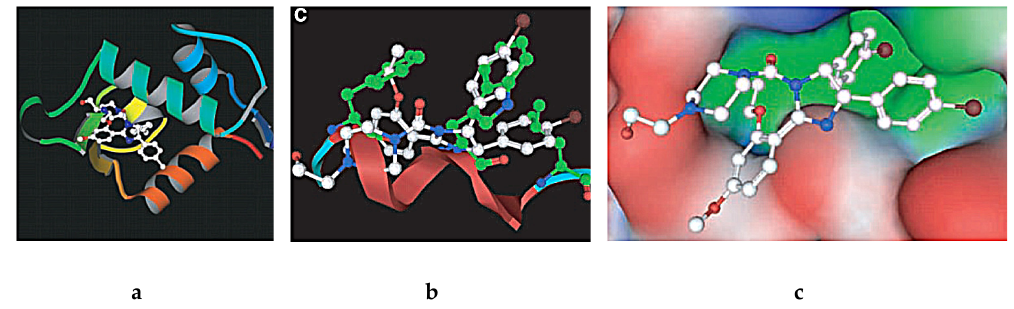
Figure 3. (a) MDM2 protein fragment with the Nutlin-3a inhibitor located at the p53 binding site. ( b ) Nutlin-3 overlay (carbon atoms are marked in white, nitrogen atoms in blue, oxygen atoms in red, and bromine in brown) and amino acid fragments of Phe19, Trp23, and Leu26 of the p53 protein. ( c ) The surface of the p53– MDM2 binding site (hollows are marked in green, and convex sections in red), showing one bromophenyl group located deep in the Trp pocket.